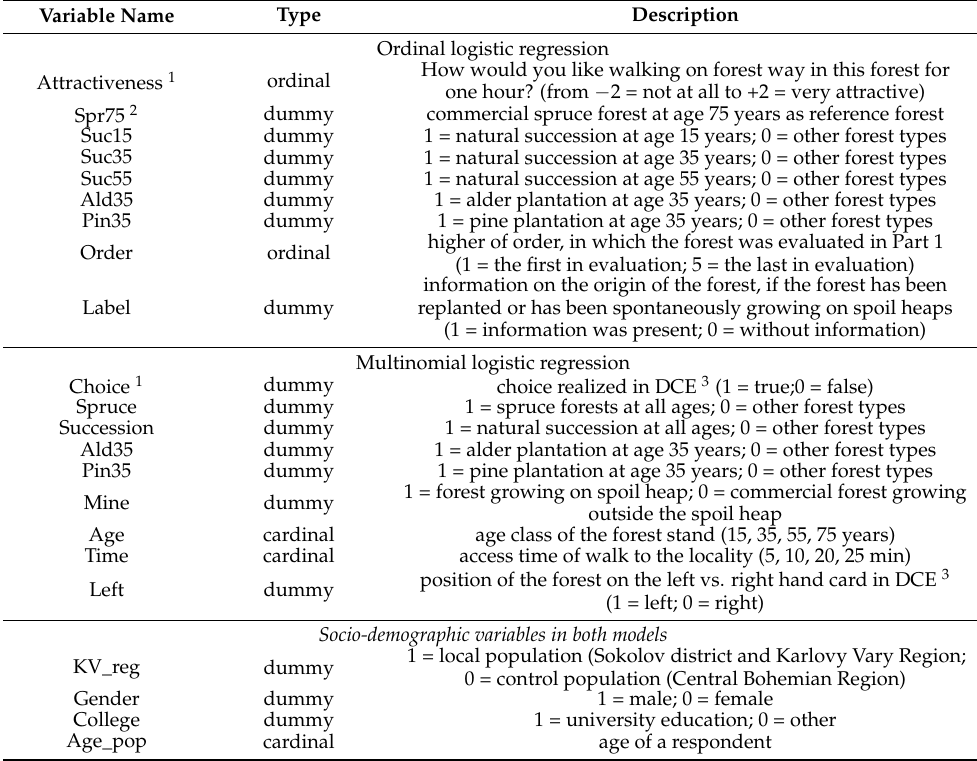
Table 2. Description of variables used in the regression